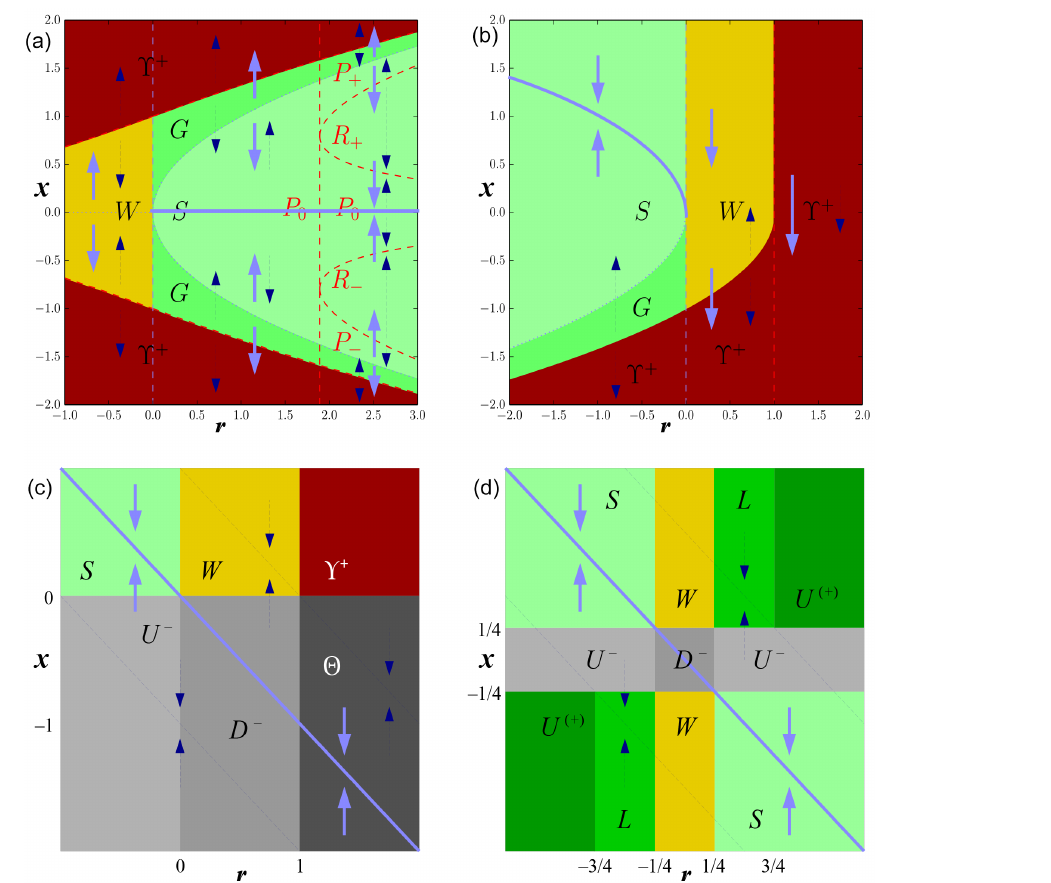
Figure B2. Parameter changes can change the quality of states due to bifurcations. Top-left panel: backwater/glade bifurcation and later port pitchfork bifurcation caused by a subcritical pitchfork bifurcation of the default flow (similar in the supercritical case). Top-right panel: glade–backwater–abyss transition caused by a saddle-node bifurcation, with the second critical value marked in red. Bottom-left panel: shelter–backwater–abyss transition caused by the transition of a stable fixed point into the deep dark. Bottom-right panel: shelter–backwater– lake–upstream transition caused by the transition of a stable fixed point through a dark